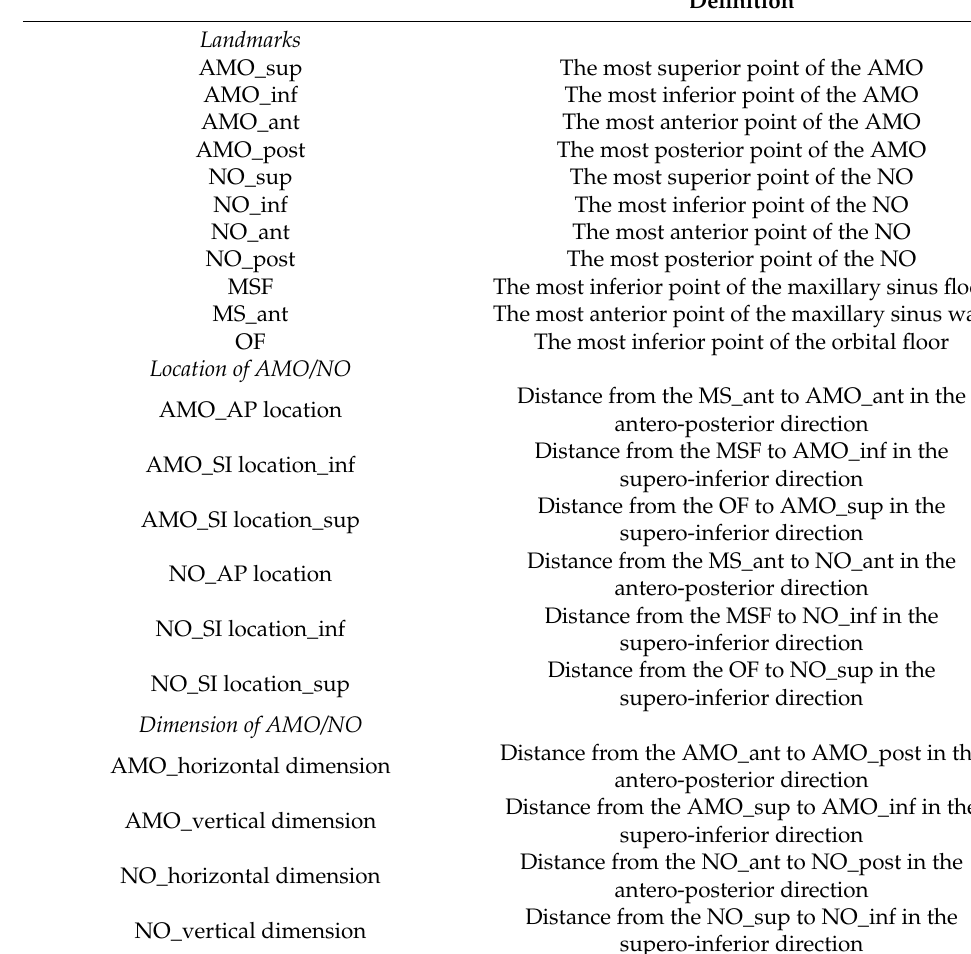
Table 1. Landmarks and measurements used in this